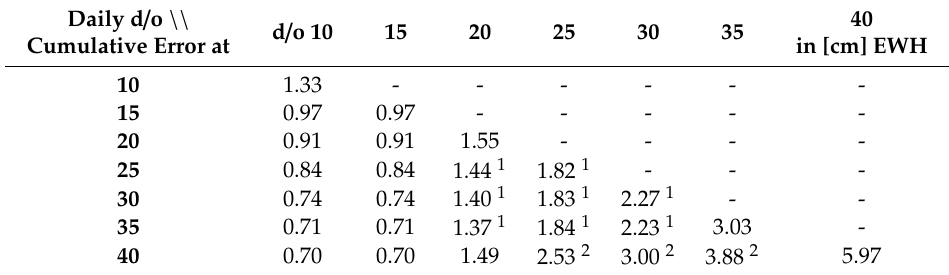
Figure 8. Degree RMS of scenario 3pii,b with di ff erent daily d / o. The nominal processing of the scenario is included as comparison. ( a ) Degree RMS average of the overall solutions, ( b ) Daily degree RMS average of the daily solutions. Compare to Table 5. Table 5. Daily cumulative error of di ff erent daily solutions from scenario 3pii,b excluding omission error in cm EWH. Compare to Table 6. The best values are marked with “1”. The values marked with “2” implicate an over-parametrization, impacting the result negatively.